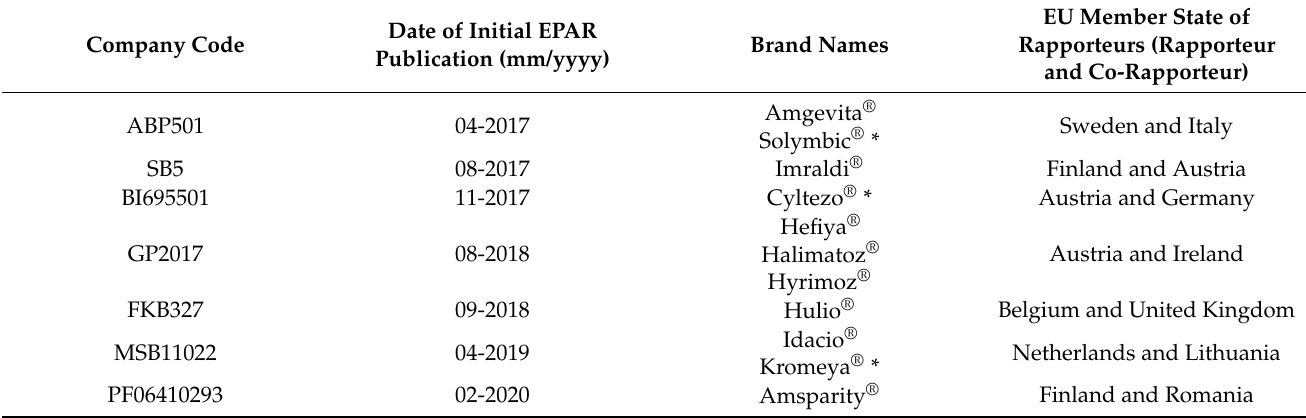
Table 1. Characteristics of the included initial European public assessment reports (EPARs) of adalimumab biosimilars